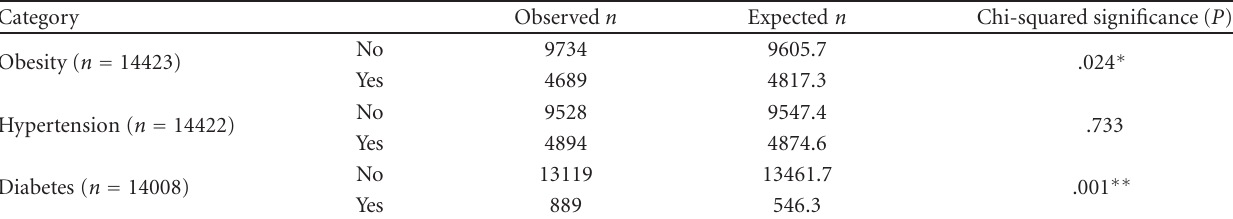
Table 2: Chi-squared “goodness of fit” for the prevalence of cardiac risk factors in participants.